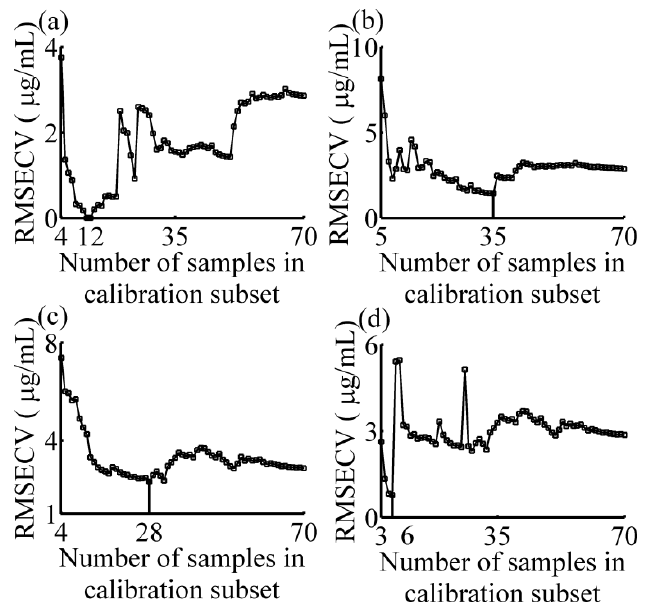
Figure 3. RMSECV of the partial least squares model as a function of the number of samples in the calibration subset. ( a ) two-component sample 1 (tartrazine: 60 μg/mL, sunset yellow FCF: 50 μg/mL); ( b ) four-component sample (amaranth: 50 μg/mL, carmine: 60 μg/mL, tartrazine: 40 μg/mL, sunset yellow FCF: 30 μg/mL); ( c ) two-component sample 2 (amaranth: 100 μg/mL, carmine: 50 μg/mL); ( d ) one-component sample (amaranth: 160 μg/mL). RMSECV: root mean square error of the cross validation.